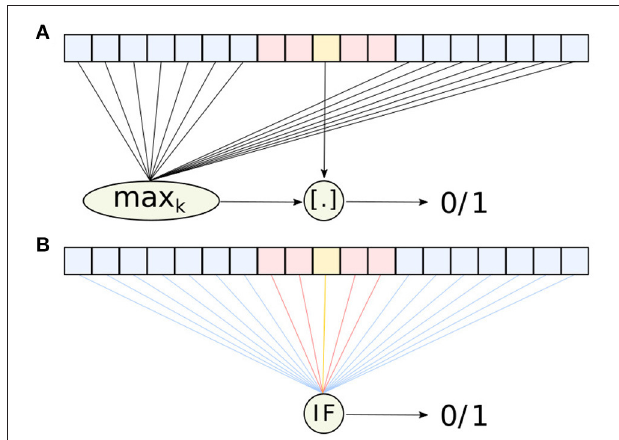
FIGURE 3 | Diagrams representing the functionality of (A) the traditional OS-CFAR algorithm, and (B) the spiking OS-CFAR algorithm described in section 2.2. The diagrams show the N neighbor cells, G guarding cells, and the value under consideration x c in blue, red, and yellow, respectively. The different connection colors indicate the weights: − 1 (blue), 0 (red), and 1 + ( k − 1) (yellow).